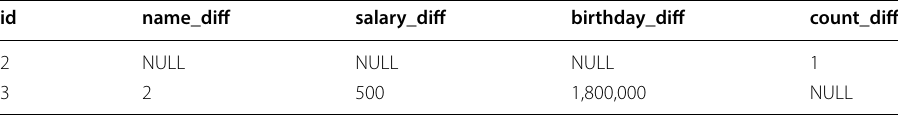
Table 9 Data in “Users_col_delta"